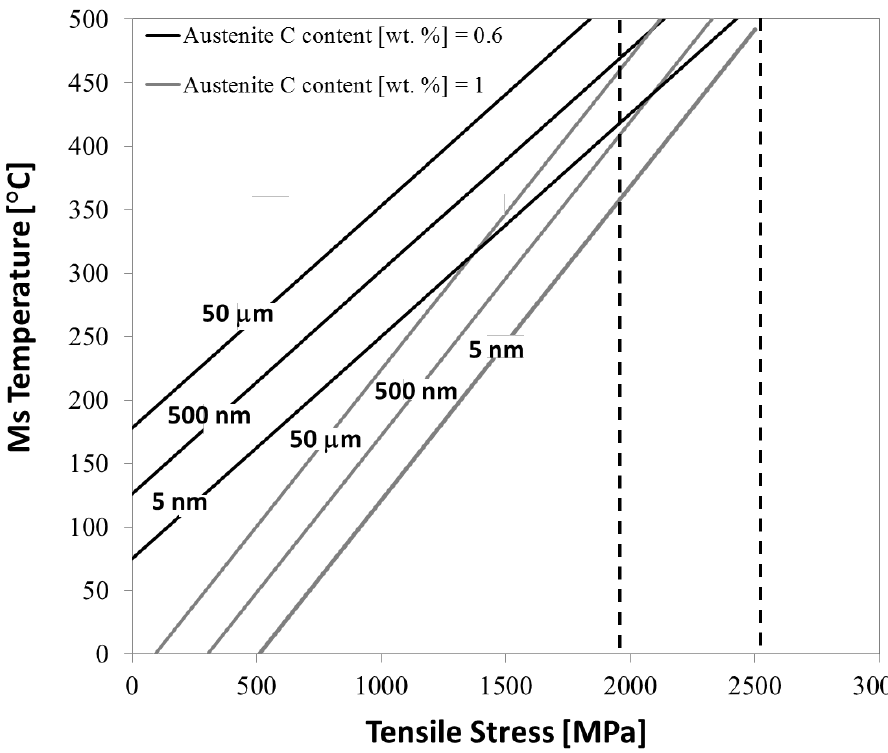
Figure 13. Theoretical values of M s (solid lines) as a function of the retained austenite C content, the austenite feature size, and the overall tensile stress, for the steel described in reference [54]. The dashed lines delimit the experimental tensile stresses over the TEM-analyzed cross sections. Adapted from reference [54].